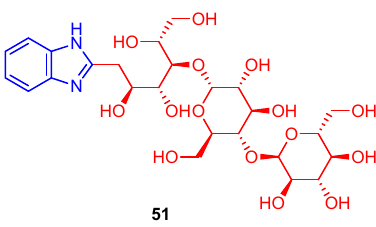
Figure 25. Oligosaccharide benzimidazole derivative.